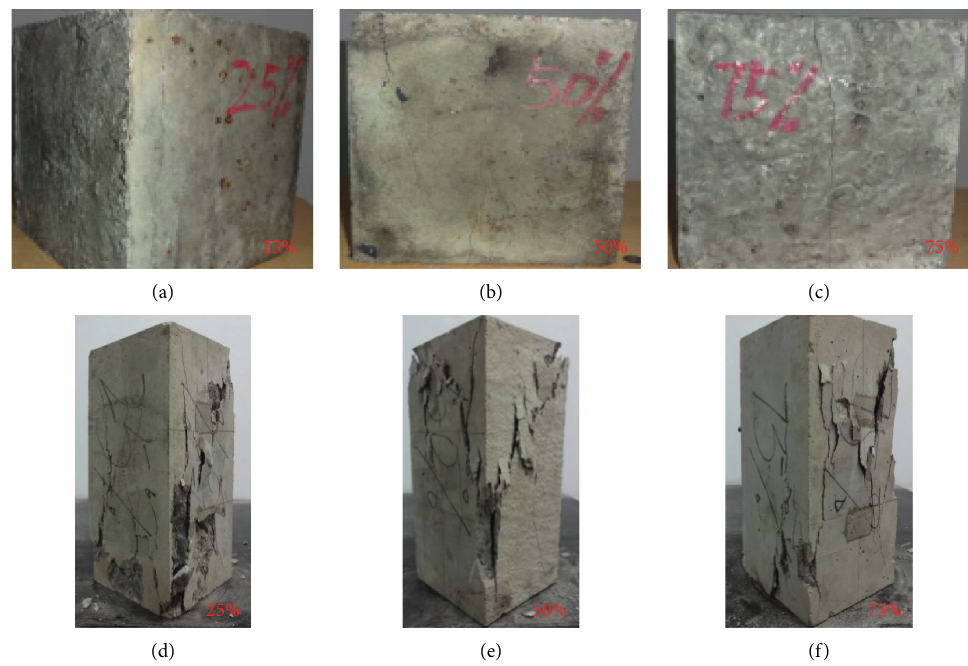
Figure 4: Failure morphology for different replacement ratios. (a) 25% replacement ratio. (b) 50% replacement ratio. (c) 75% replacement ratio. (d) 25% replacement ratio. (e) 50% replacement ratio. (f) 75% replacement ratio.